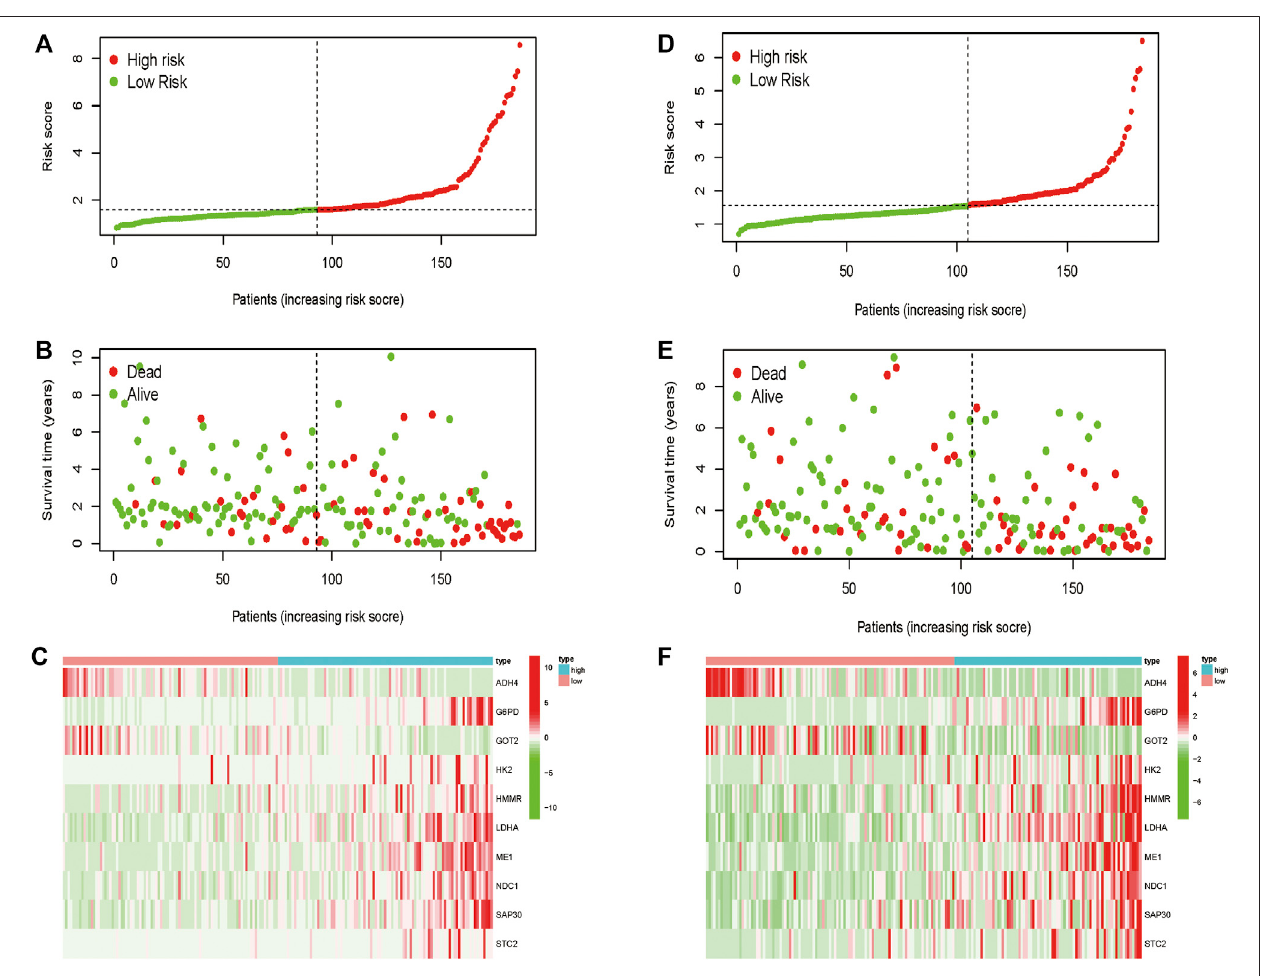
FIGURE 6 | Distribution of the risk score, overall survival, and gene expressions in the training cohort (A – C) and the validation cohort (D – F) .